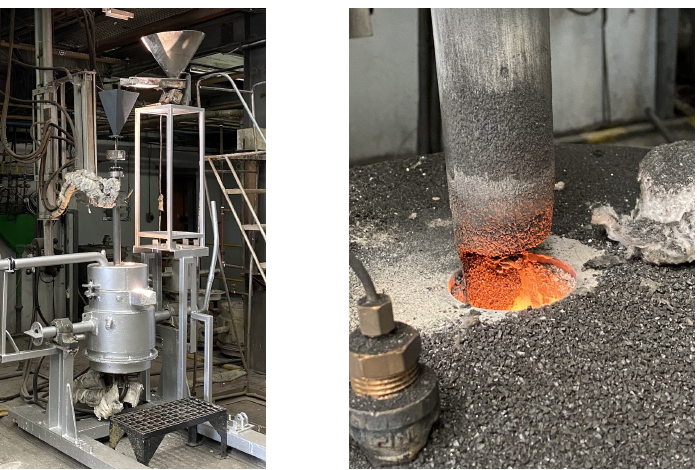
Figure 4. The 100 kVA DC plasma arc furnace pilot facility at Mintek. The furnace vessel is the silver cylinder at lower middle in the left image. A close-up of the electrode extracted from the furnace is shown on the right.